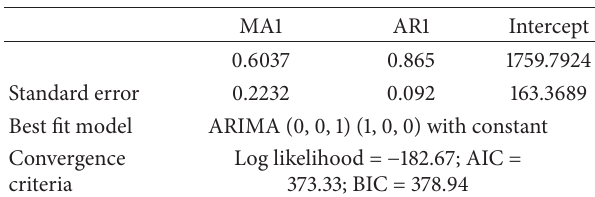
Table 1: Estimation of the coefficient of the best fit model for the TB case finding time